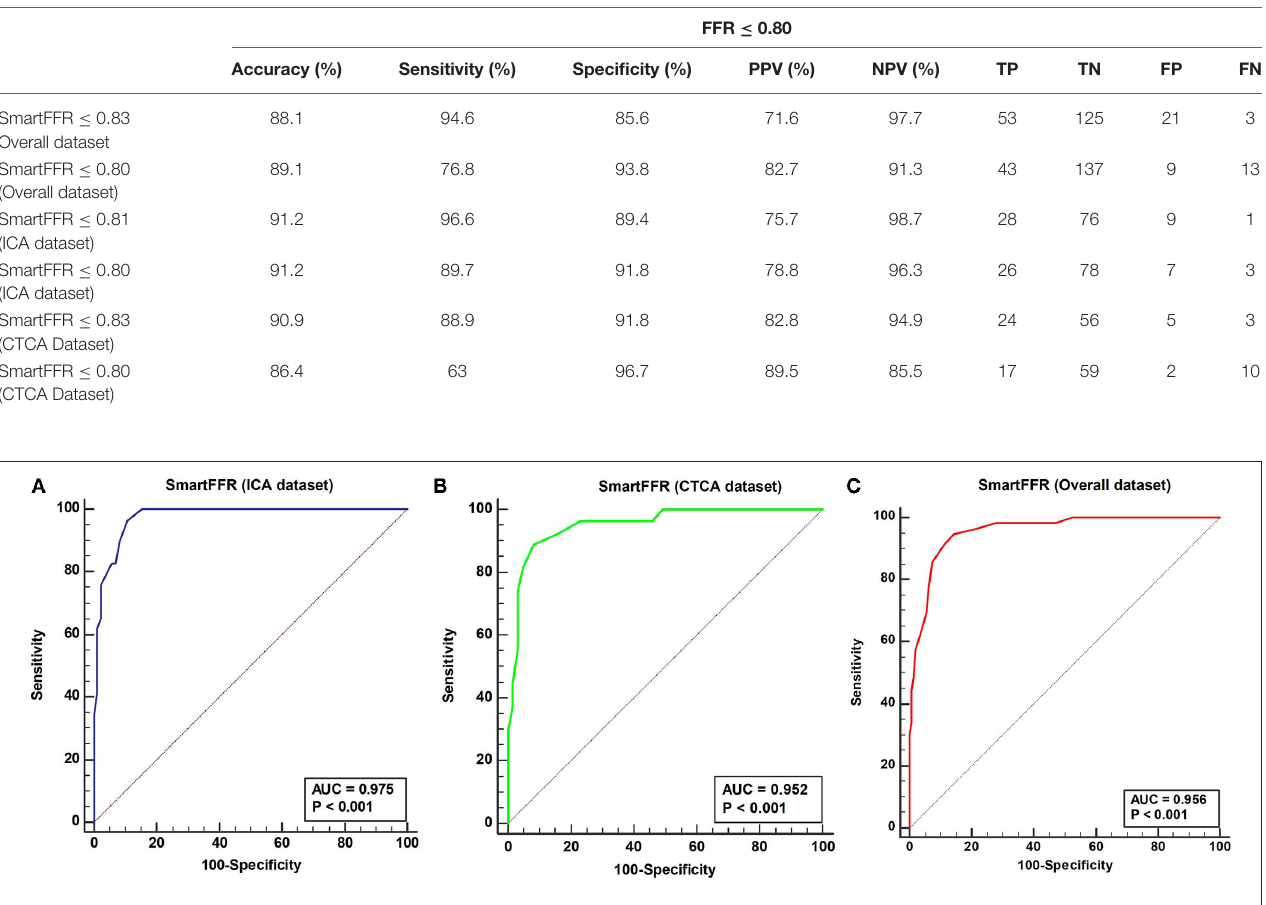
FIGURE 6 | ROC curve depicting the diagnostic performance of SmartFFR for (A) ICA dataset (95% CI 0.91–0.98), (B) CTCA dataset (95% CI 0.88–0.99) and (C) Overall dataset (95% CI: 0.92 to 0.98).